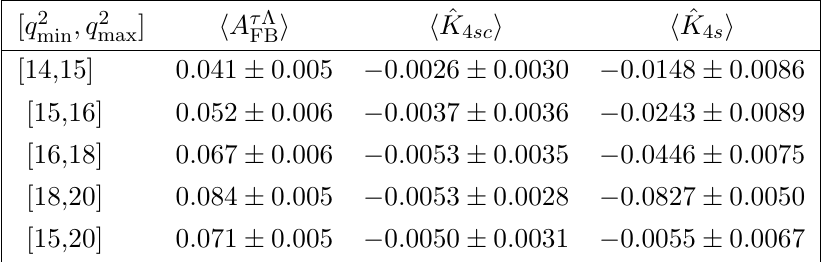
Table 2 . The values of the observables in di(cid:11)erent q 2 bins (in GeV 2 ). The errors correspond to the uncertainties discussed in